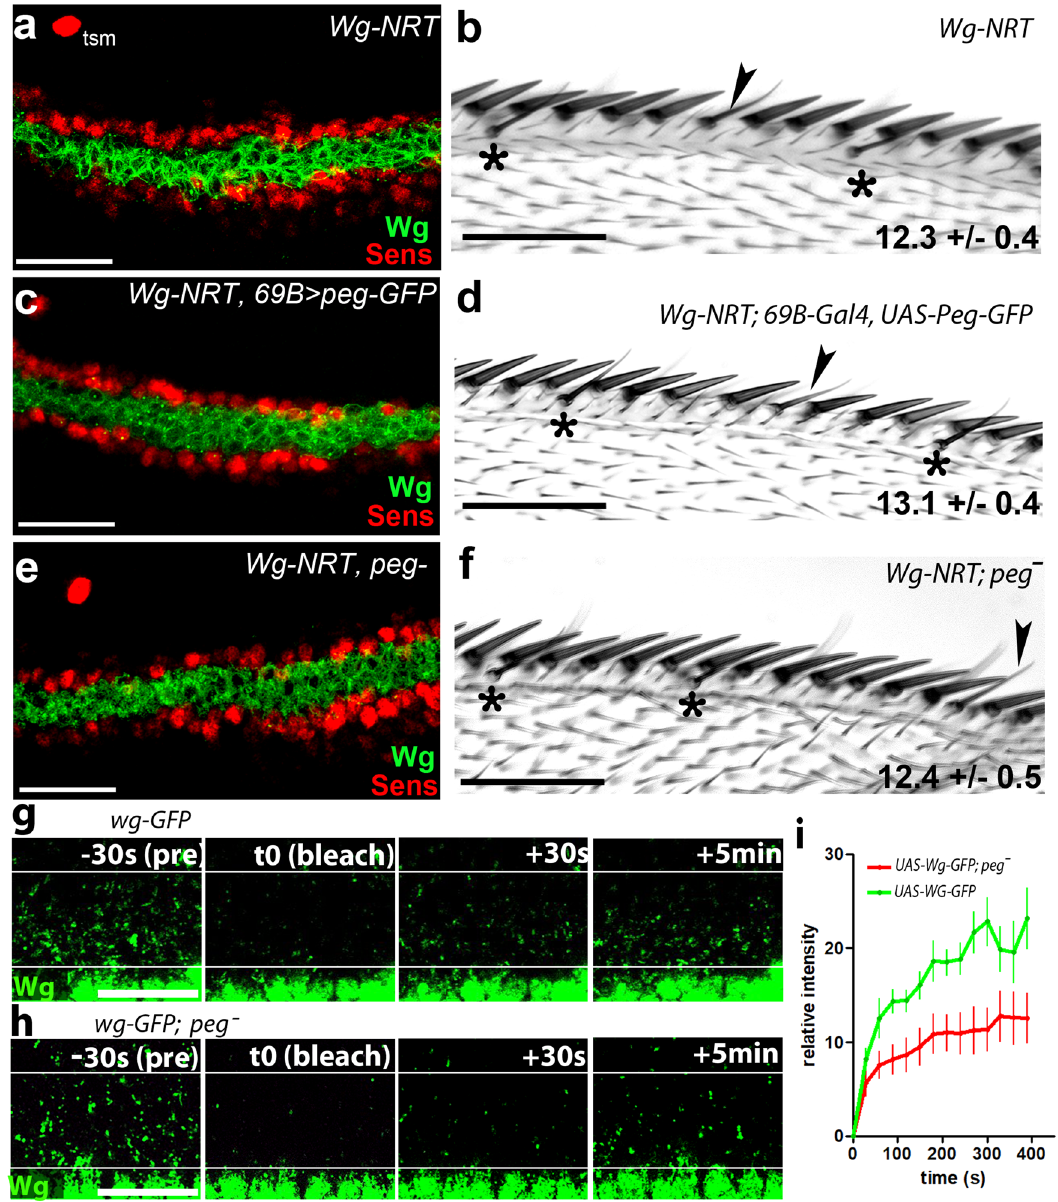
Fig. 5 Peg acts directly on Wg protein. a In wg NRT wing discs Wg (green) fails to diffuse away from the expressing cells, and Sens expression (red) is strongly reduced compared to wild type (Fig. 2c, quanti fi cations in Fig. S2a-c, f). Note unaffected tsm. b wg NRT wings have fewer chemosensory bristles (*) (sometimes misplaced, arrowheads). c - f Neither the bristle phenotype, nor sens expression are affected by over-expression of PegGFP (c,d), or by Peg removal ( e , f ) (quanti fi ed in Fig. 2e). g - h . In-vivo FRAP imaging of WgGFP (activated by ptc-GAL4 UAS-Gal80 ts , 24 h before dissection) before (pre), immediately after (t0, bleach), 30 seconds, and 5 min after photo-bleaching (performed between white lines), in a wild-type ( g ) or a peg - ( h ) background (see also Supplementary Movies 1 and 2). i FRAP quanti fi cation from panels g - h , showing average fl uorescence intensity within the bleached region, over time, relative to the intensity before bleaching (pre). Acquisition was made every 30 s. Error bars represent SEM ( n = 5 movies per genotype). Source data are provided as a Source Data fi le. Scale bars: a , c , e , g , h : 20 µ m; b , d , f : 50 µ The UAS-pegGFP and zPegGFP plasmids were sent to BESTgene for injection phenotypes, stocks were established from putative peg mutants, and peg alleles were into embryos and generation of transgenic fl ies. con fi rmed by PCR of the locus followed by sequencing. Generation of the Peg-Gal4 line (see also Fig. S9) . The peg-Gal4 line was Generation of CRISPR mutants . To generate the peg - null mutants we cloned the generated by CRISPR- mediated homology-directed genome editing using the strategy reported by Gratz et. al 35 , co-injecting the following plasmids in a Vasa- following guide sequence targeting the CDS of CG17278: GTACCGATCCAT TTGCGCTGCGG into the pU6-BbsI-chiRNA plasmid, obtained from addgene , and cas9 Drosophila line: a pFCD4 vector carrying tandem RNA guides introduced with following the available protocol (http://FlyCRISPR.molbio.wisc.edu). The following the primers Tan-CG17278_3 ′ guide_Rv and Tan-CG17278_5 ′ guide_Fw (see primers were used: chi-CG17278_ORF_guide_1_Fw and chi-CG17278_ORF_guide_ Table S4 for primer sequences), following the protocol described in 35 ; and the 1_Rv (see Table S4 for primer sequences). The pU6-CG17278-chiRNA plasmid was pTV[cherry] 36 vector carrying 1 kb homology arms targeting the 5 ′ and 3 ′ regions then sent for injection to BESTgene into the y[M{vas-Cas9}ZH2A w line. Surviving of peg (see Fig. S9) designed to remove the whole peg locus while maintaining its adults were crossed to w;;Df(3 R)BSC680 , the progeny was scored for peg - like presumptive regulatory regions. Successful peg pTV CRISPR-mediated homologous